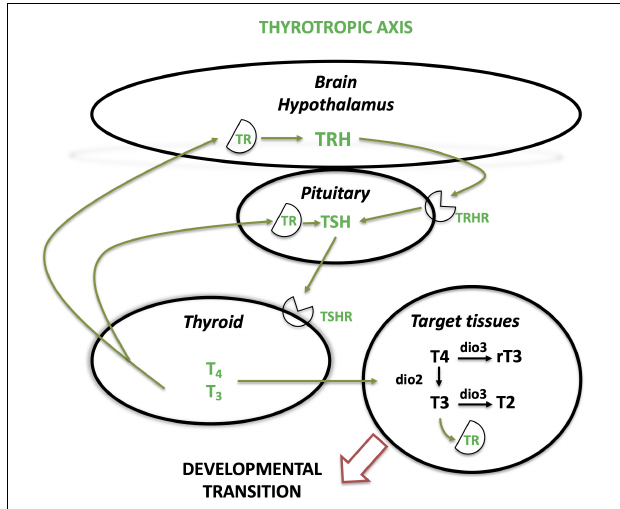
FIGURE 2 | Thyrotropic neuroendocrine axis in vertebrates. The figure displays the main actors of the thyrotropic (hypothalamic-pituitary-thyroid, HPT) axis. dio, deiodinase; T 4 , thyroxine; T 3 , tri-iodothyronine; rT 3 , reverse triiodothyronine; T 2 , diiodothyronine; TR, thyroid hormone receptor; TRH, thyrotropin releasing hormone; TRHR, thyrotropin releasing hormone receptor; TSH, thyrotropin; TSHR, thyrotropin receptor.